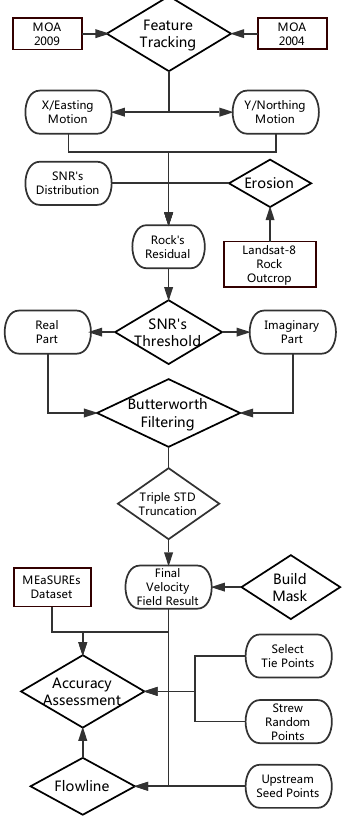
Figure 1. Flowchart of processing and analysis